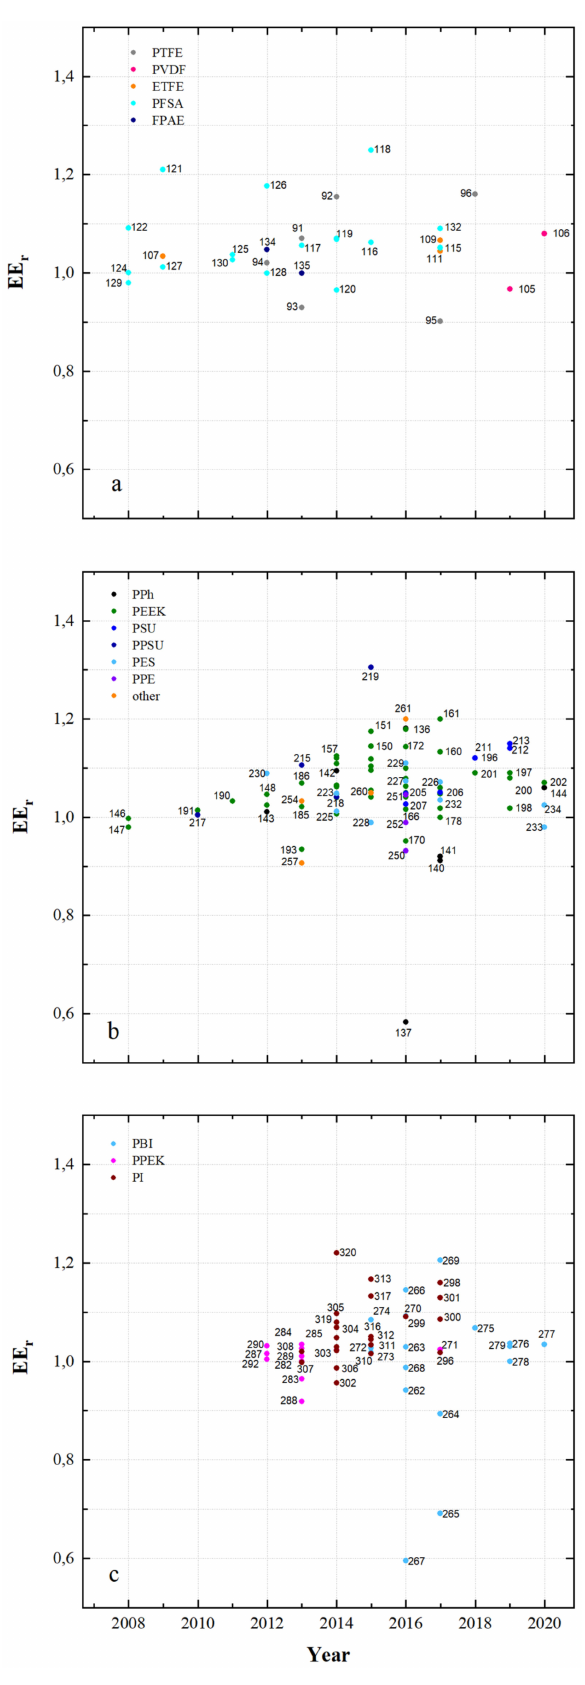
Figure 15. Energy efficiency ratios in recent years: ( a ) fluoro-carbons, ( b ) hydro-carbons and ( c ) N